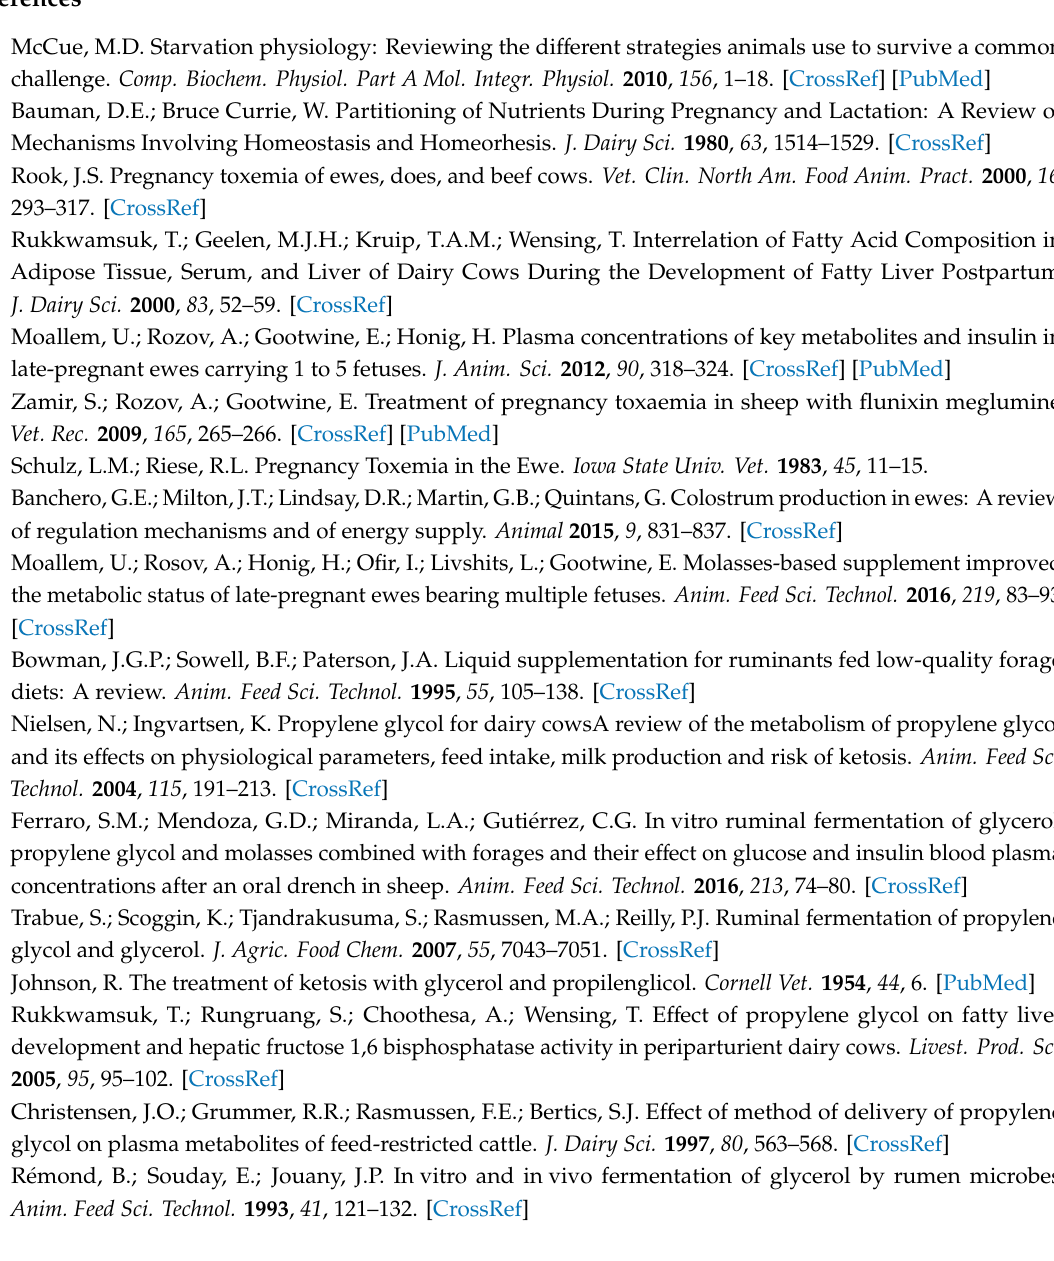
Figure S1: Glucose blood concentration in response to propylene glycol and the glycerol intravenous treatments, Figure S2: Representative plasma samples isolated form sheep treated with glycerol (left) and propylene glycol